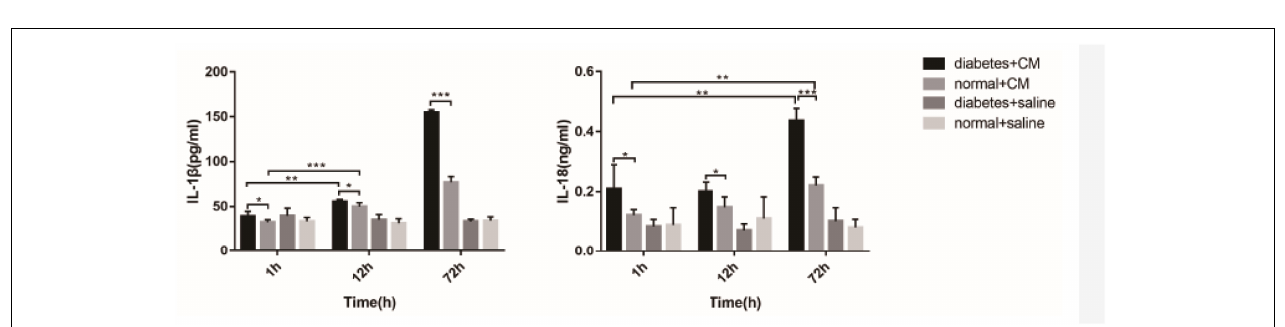
FIGURE 11 | IL-1 β and IL-18 in serum. * P < 0.05, ** P < 0.005, *** P < 0.0001. IL-1 β , interleukin-1 β ; IL-18, interleukin-1 β